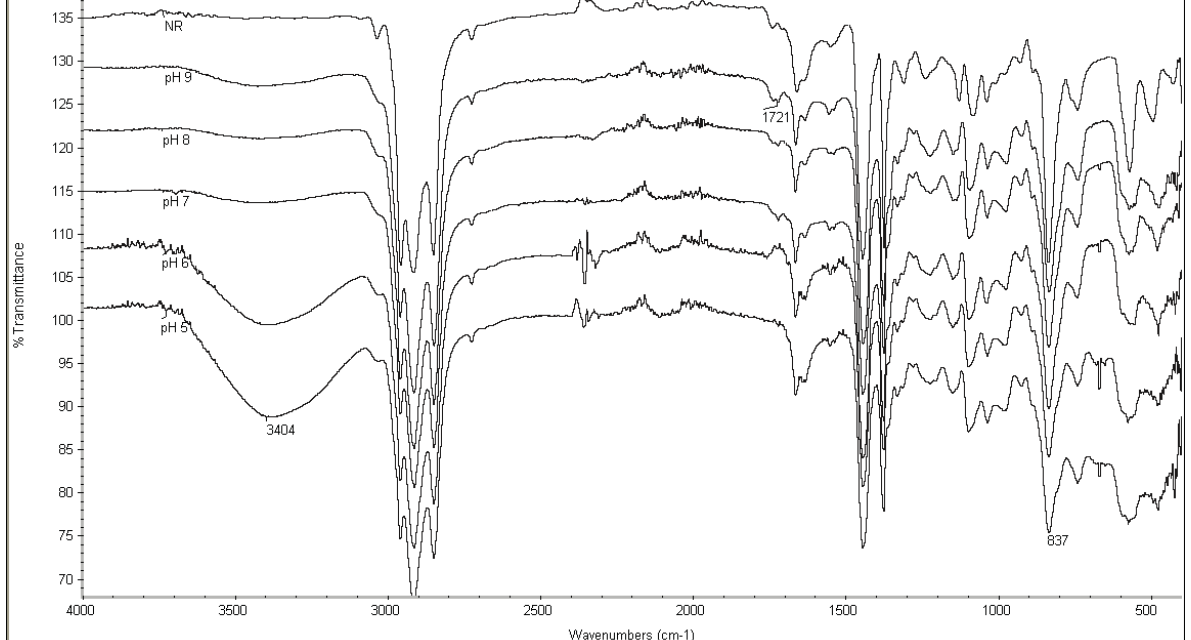
Figure 1. FTIR spectra of liquid natural rubber (LNR) samples prepared at different pH of